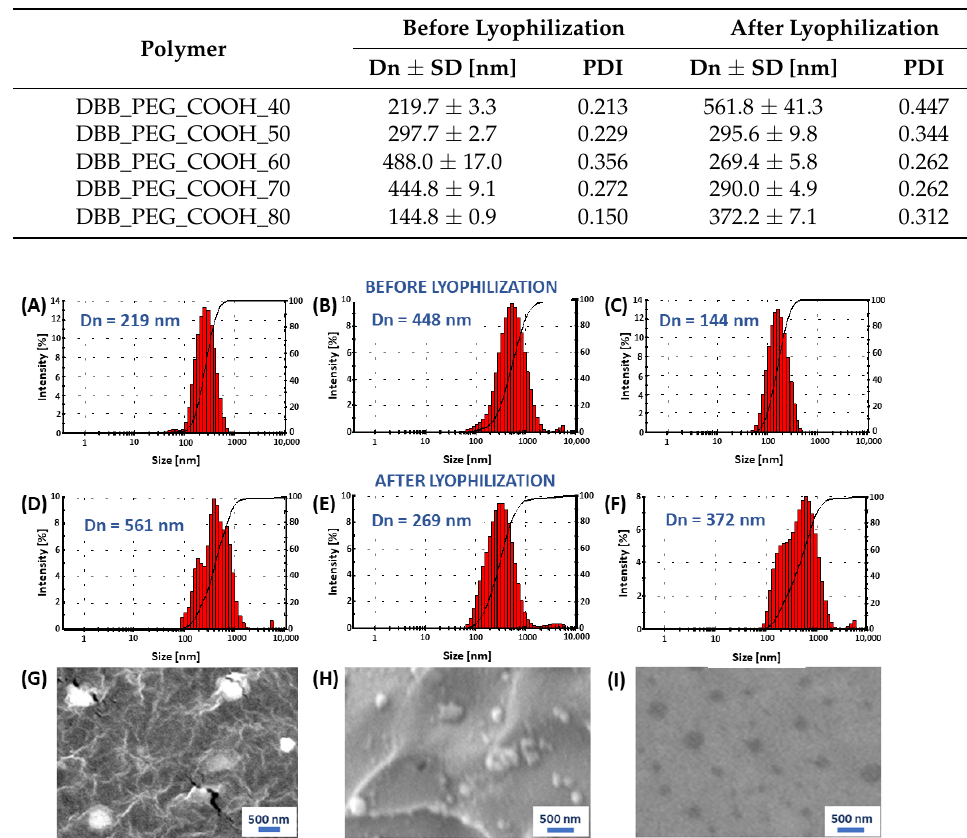
Figure 13. The size distribution of micelles before lyophilization: from polyDBB_PEG_COOH_40 ( A ), polyDBB_PEG_COOH_60 ( B ) polyDBB_PEG_COOH_80 ( C ); after lyophilization: from polyDBB_PEG_COOH_40 ( D ), polyDBB_PEG_COOH_60 ( E ), polyDBB_PEG_COOH_80 ( F ) and their morphologies after lyophilization ( G – I ) characterized by SEM.